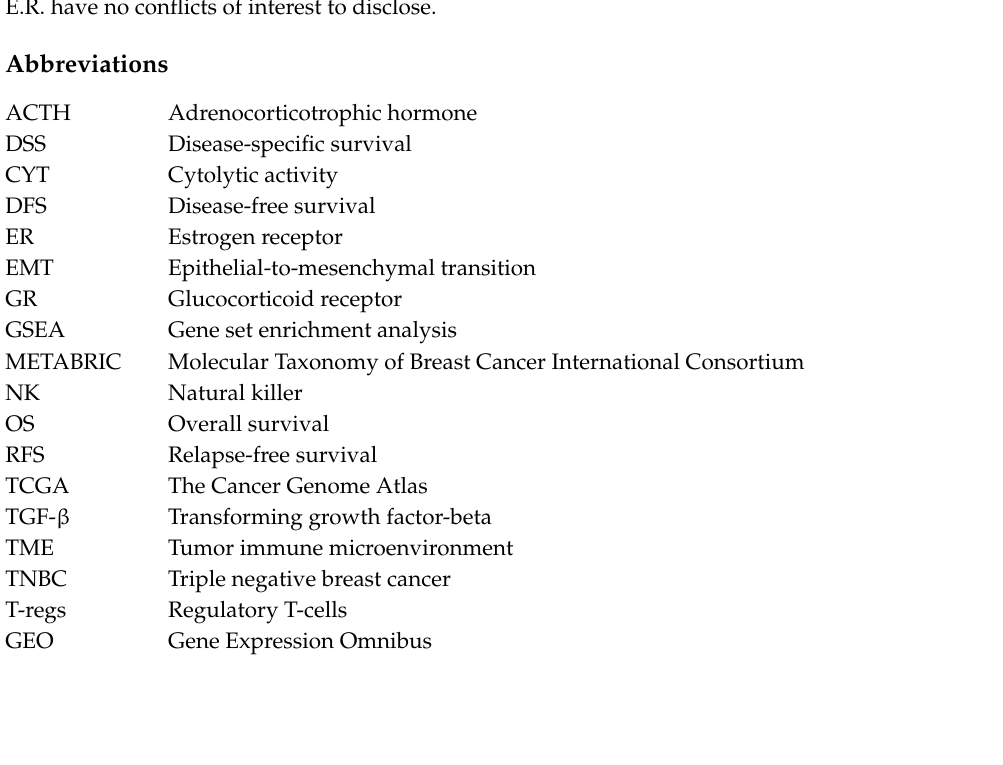
Figure S1: Highest and lowest quartiles (25%) of NR3C1 RNA-seq expression as a cuto ff to identify “High” and “Low” GR ( NR3C1 ) tumor expression, respectively, Figure S2: GR expression and survival outcomes in breast cancer. Kaplan-Meier survival plots comparing patients with high and low GR expression along with logrank test p values and hazard ratios (HR) with confidence intervals are shown for disease-free ( DFS ), disease-specific ( DSS ) and overall survival ( OS ) for sub-groups of (A) estrogen receptor ( ER )-positive and (B) human epidermal growth factor receptor ( HER2 )-positive breast cancer. The cut-o ff of top and bottom quartile of NR3C1 expression was considered as GR high and GR low in the respective subtypes. Log-rank test was used to compare the survival between GR high and GR low breast cancer, Figure S3: Correlation between GR expression and macrophages across di ff erent immune cell composition algorithms (EPIC, TIMER, CIBERSORT, xCELL), Figure S4: Hallmark gene sets with significant enrichment in GR high and low breast cancer with FDR <